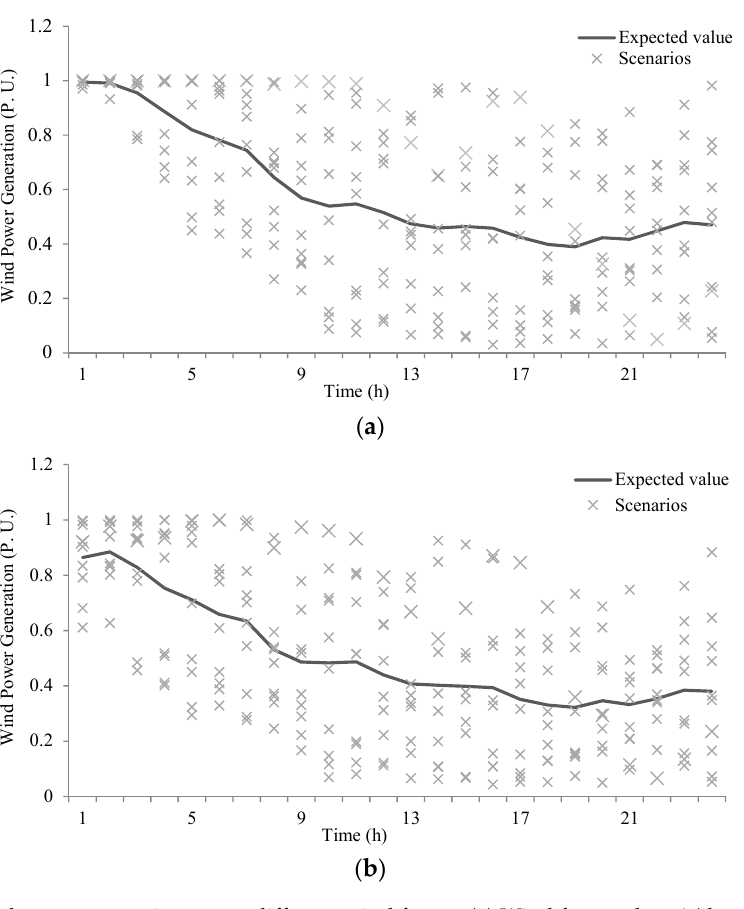
Figure 2. Wind power scenarios at two different wind farms. ( a ) Wind farm at bus 4 (downward wind farm). ( b ) Wind farm at bus 22 (upward wind farm).